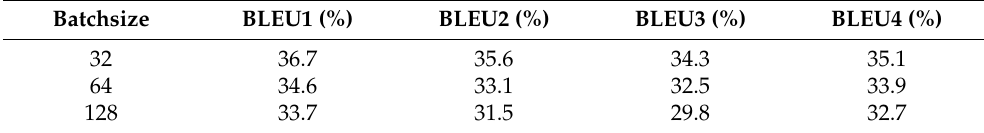
Table 2. Bleu value of ResLSTM-Attention-Seq2seq under different batch sizes.